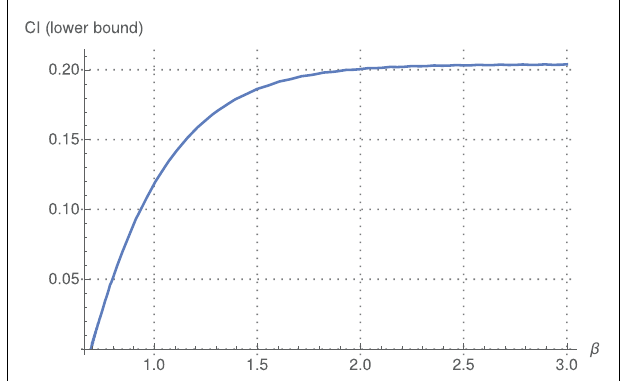
FIGURE 12 | Lower bound for CI versus (cid:12) . For each (cid:12) ∈ [0.7, 3] we can find an (cid:11) such that the joint p (cid:11) k (cid:12) lies in ∧ . The increase in mutual information as (cid:12) varies is a lower bound for CI , which is then in general